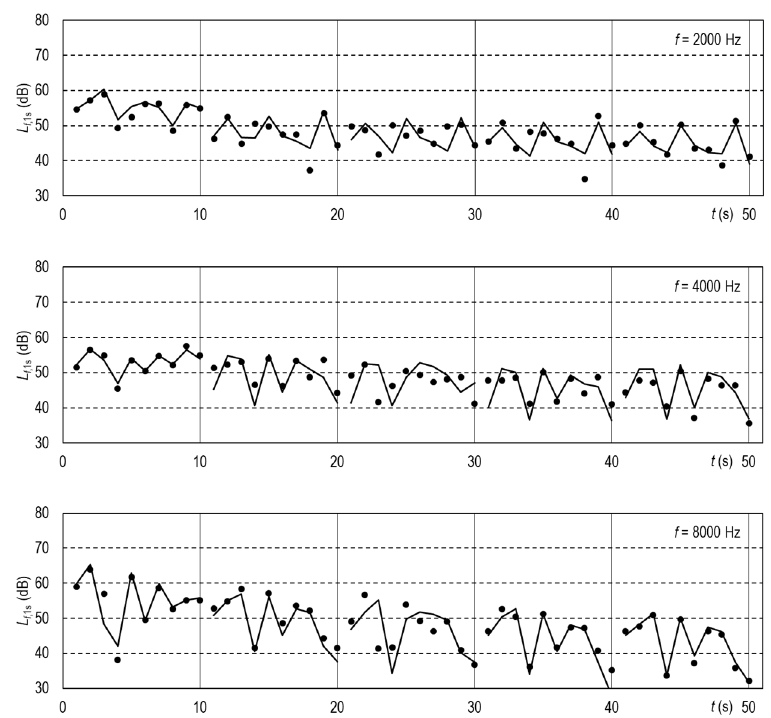
Figure 4. Time series of the sound pressure levels for the FFP1 in octave bands averaged for 1 s-long intervals. Five 10 s-long samples of the simulated human speech emitted by the TalkBox and recorded at distances (from left to right): 1 m, 2 m, 3 m, 4 m, and 5 m. Points—measured values, vertices of the broken lines—values calculated from the FFP attenuation characteristics; the lines themselves are guides for the eye only.